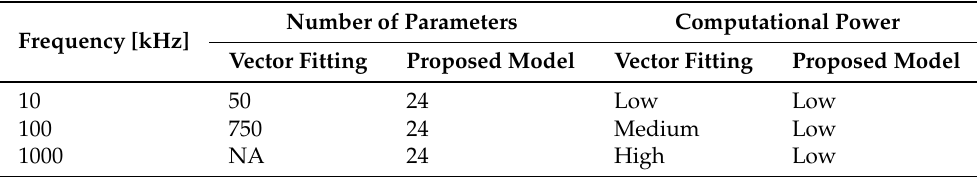
Table 13. Comparison between VF and the proposed model.